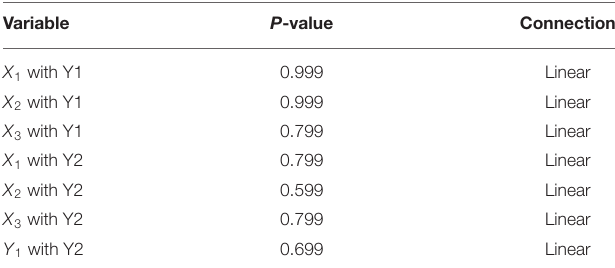
TABLE 4 | Linearity test results.